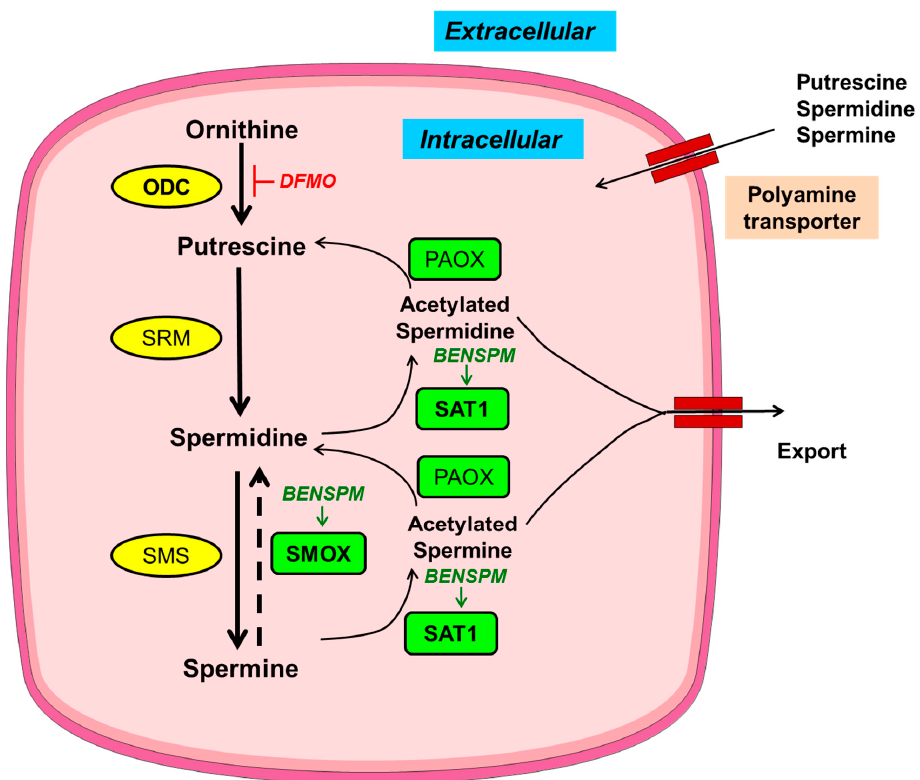
Figure 1. Schematic depiction of polyamine metabolism and transport. Anabolic and catabolic enzymes in yellow circles or green rectangles, respectively, with key metabolic enzymes in bold.